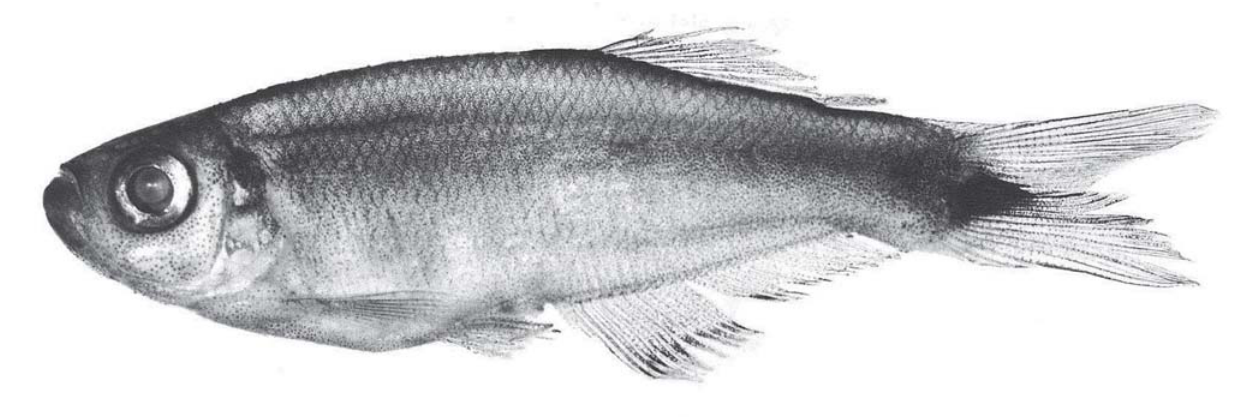
Fig. 63. Mimagoniates sylvicola , young adult male, MZUSP 36612, holotype, 30.2 mm SL, Brazil, Bahia, município de Prado,